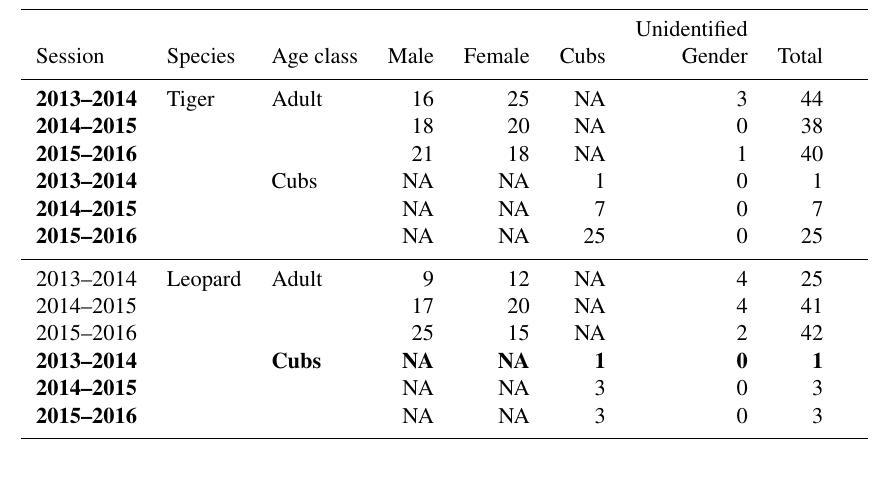
Table A2. Details of camera trap-based photographs of individually identified tigers and leopards over the entire study period (2013–2016). The bold highlighted portion includes photo capture details of cubs of tigers and leopards, respectively, which were not included for analysis. NA stands for not applicable.